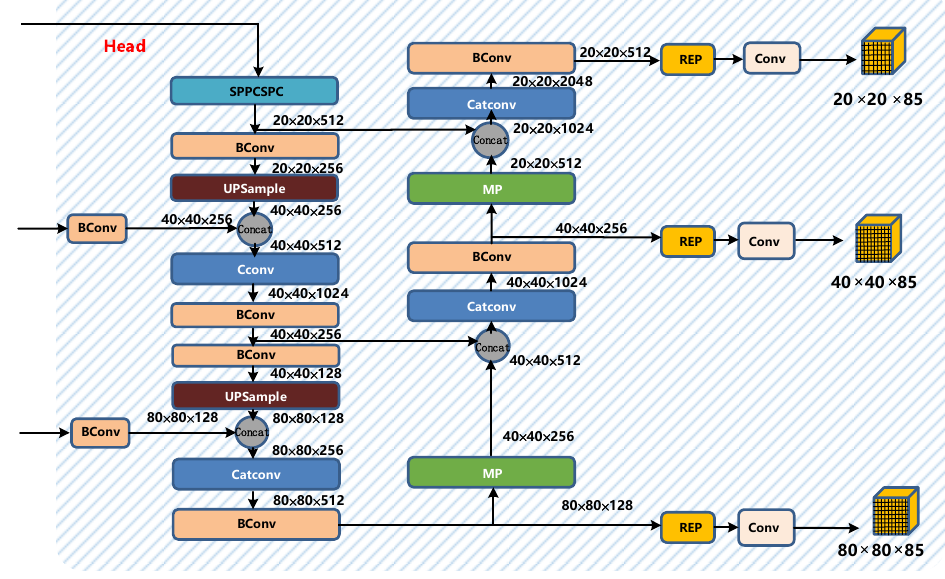
Figure 10. Head structure diagram of YOLOv7.